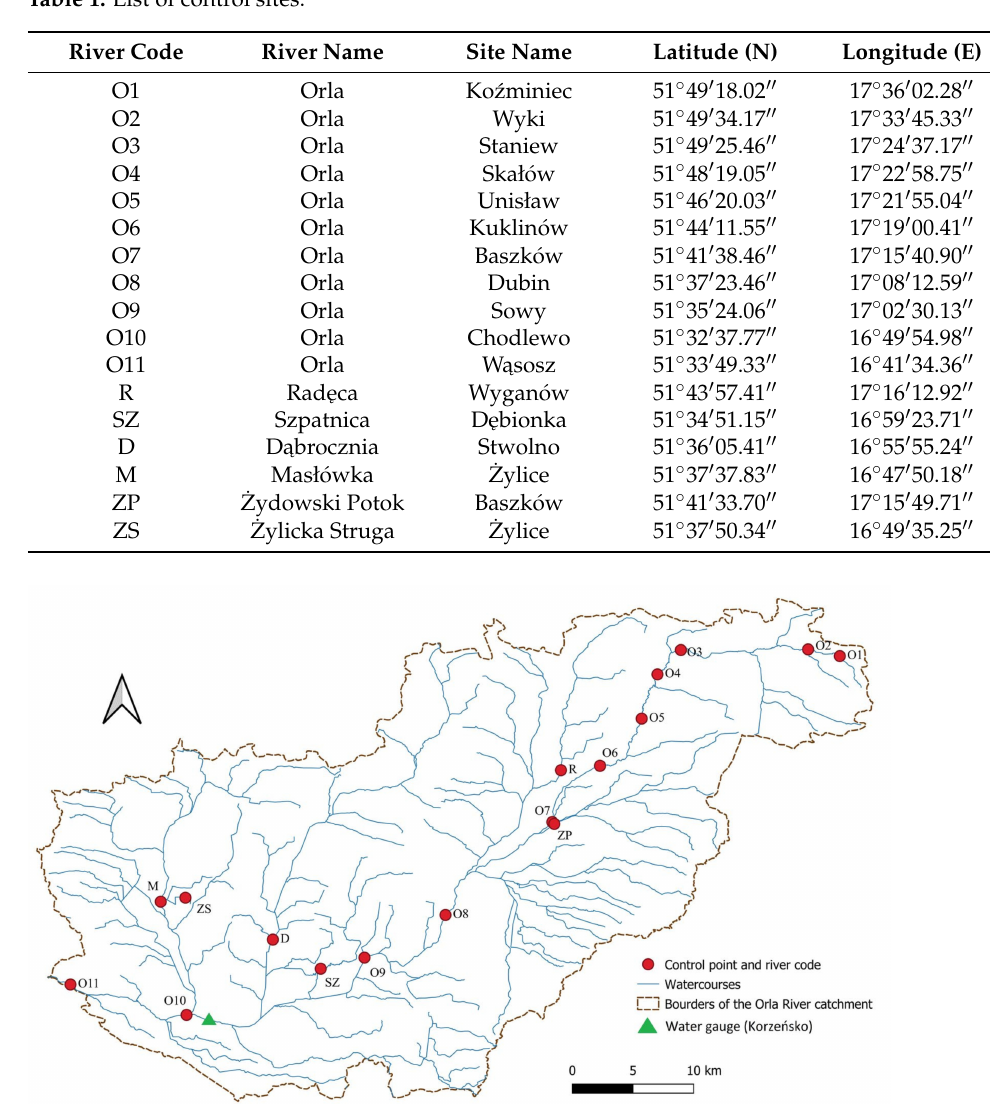
Table 1. List of control sites.